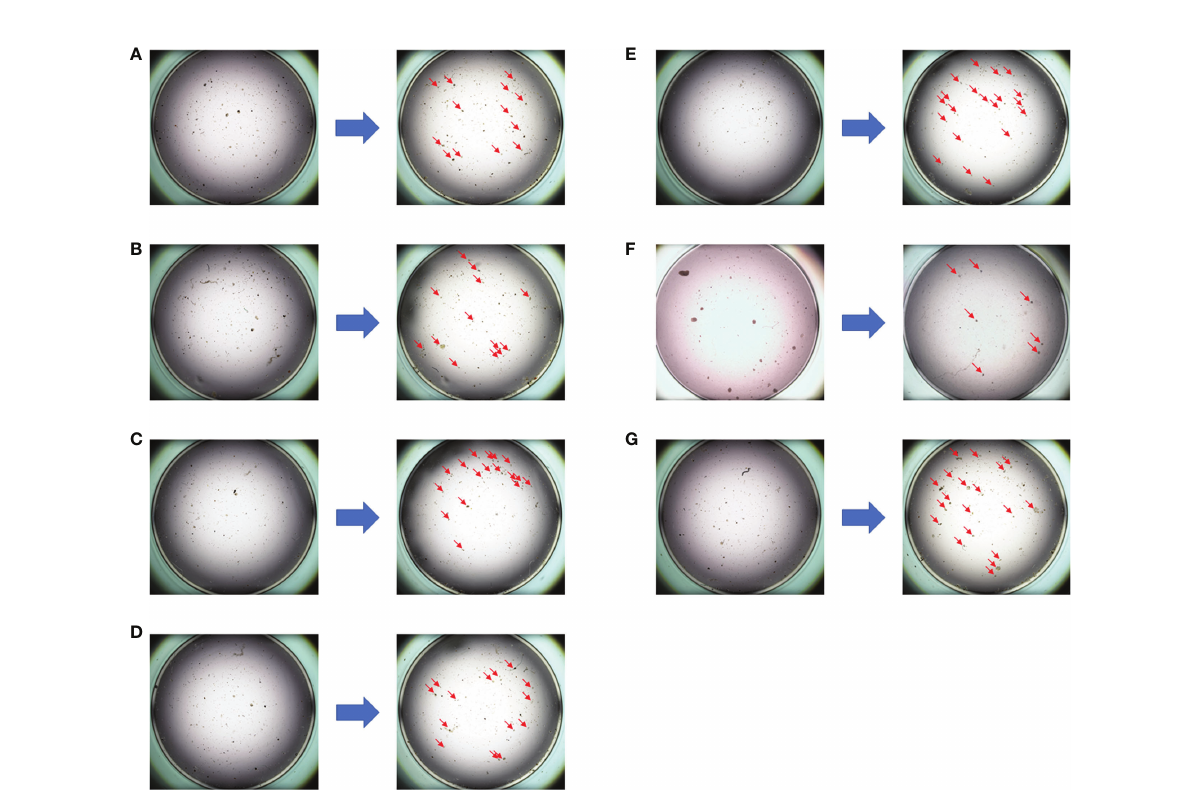
FIGURE 4 The drug sensitivity results of the PTC model for individualized treatment in case 2. (A) Comparison of albumin paclitaxel + capecitabine + trastuzumab before and after dosing; (B) comparison of albumin paclitaxel + carboplatin + trastuzumab before and after dosing; (C) comparison of albumin paclitaxel + carboplatin before and after dosing; (D) comparison of pyrotinib + capecitabine before and after dosing; (E) comparison of epirubicin before and after dosing; (F) comparison of albumin paclitaxel + trastuzumab + pertuzumab before and after dosing; (G) negative control (NC)